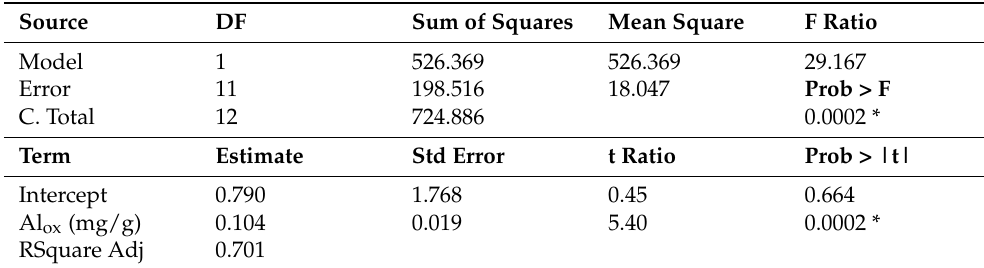
Table 4. Simple linear model between q m and Al ox